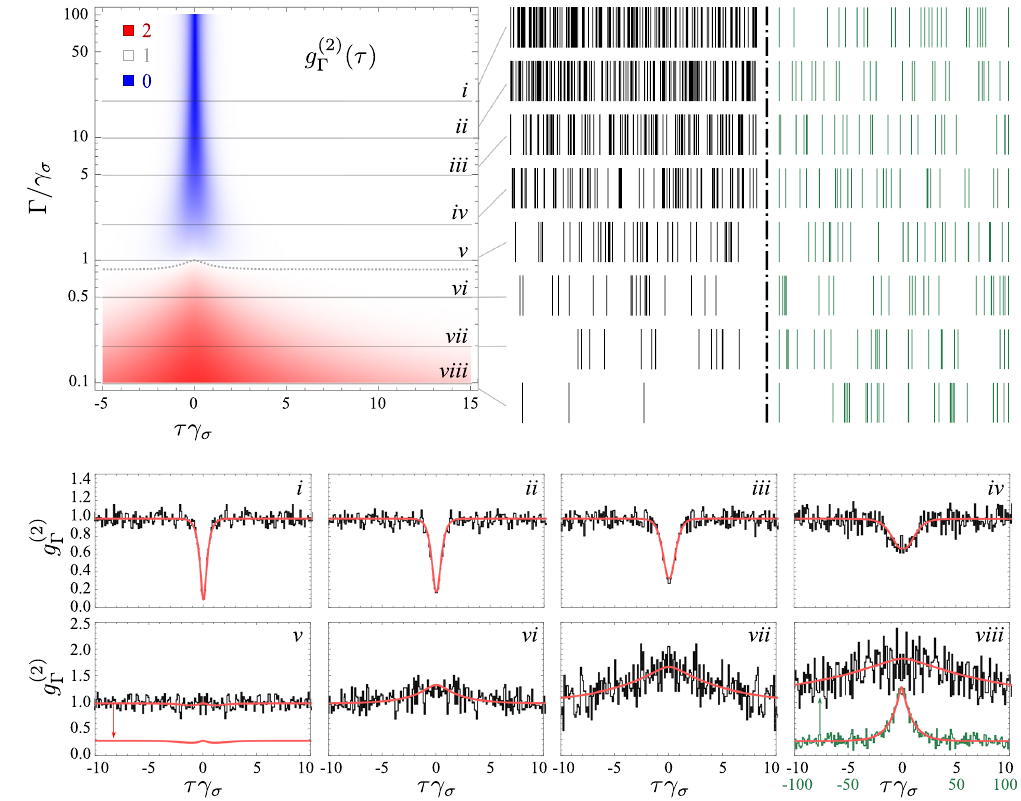
Figure 3. Frequency-resolved emission from an incoherently driven two-level system. The number of events (clicks) recorded are close to 10 000 (namely 9976, 9916, 9974, 9927, 9967, 9955, 9860) for the cases i – vii respectively, and 25 000 for case viii to get enough signal for the small timescale comparison to the other filters. The density-plot is the theoretical τ g ( ) (2) with the color code indicated (blue for antibunching, red for bunching Γ and white for uncorrelated). Filtering leads to thermalization. The transition is slightly more complex than merely loss of antibunching. The dotted line shows the isoline τ = g ( ) 1 (2) . Monte Carlo simulations have been Γ done for the eight cuts shown. Samples of clicks are shown in the same time window (black, left) or with rescaling to have the same intensity (green, right). There is a neat transition visible to the naked eye between the two types of photon statistics. Autocorrelation computed from the clicks are shown in the eight panels at the bottom, together with the theory prediction. In panel v , the theory curve is also shown displayed to reveal its fine structure departing from τ = g ( ) 1 (2) . In panel viii , also the case of longer times is shown since Γ thermalization goes together with slowing down of the dynamics. For the density plot 1/ γ σ sets the unit and P σ = 2 γ σ . The clicks correspond to the emission events of the operator c 3 in Eq.